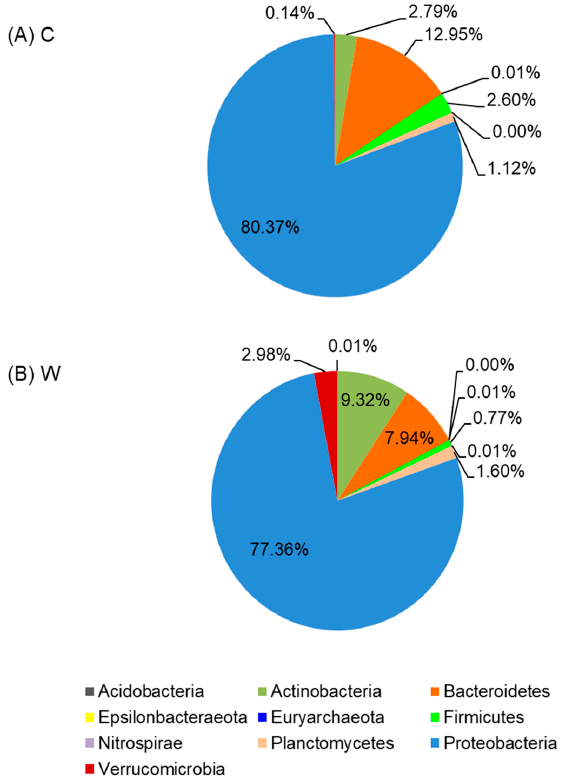
Figure 7. Average phylum distributions of intestinal microbiota of shrimp in control ( A ), and W5 ( B ) groups .